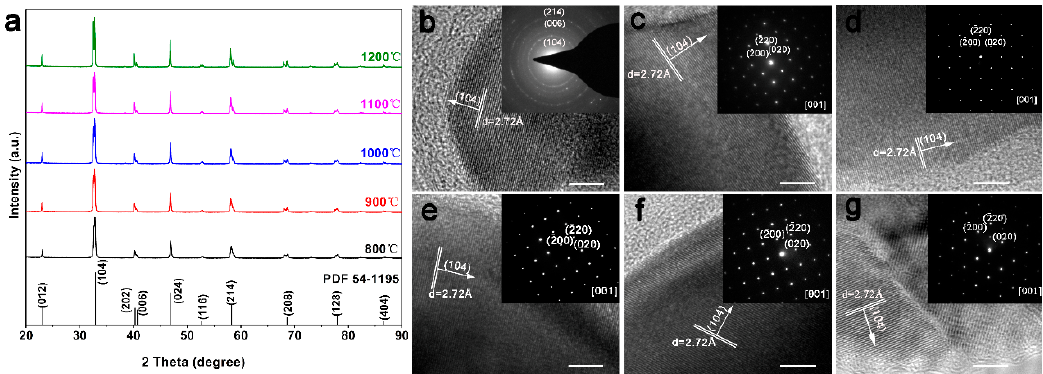
Figure 2. ( a ) The XRD spectra of LSM sintered bodies at different sintering temperatures; ( b ) the high-resolution transmission electron microscopy (HR-TEM) and selected area electron diffraction (SAED) image of pristine LSM powders; ( c – g ) The HR-TEM and SAED images of LSM sintered bodies at different sintering temperatures, 800 °C ( c ), 900 °C ( d ), 1000 °C ( e ), 1100 °C ( f ), 1200 °C ( g ), respectively. The scale bars in the TEM images indicate 5 nm.